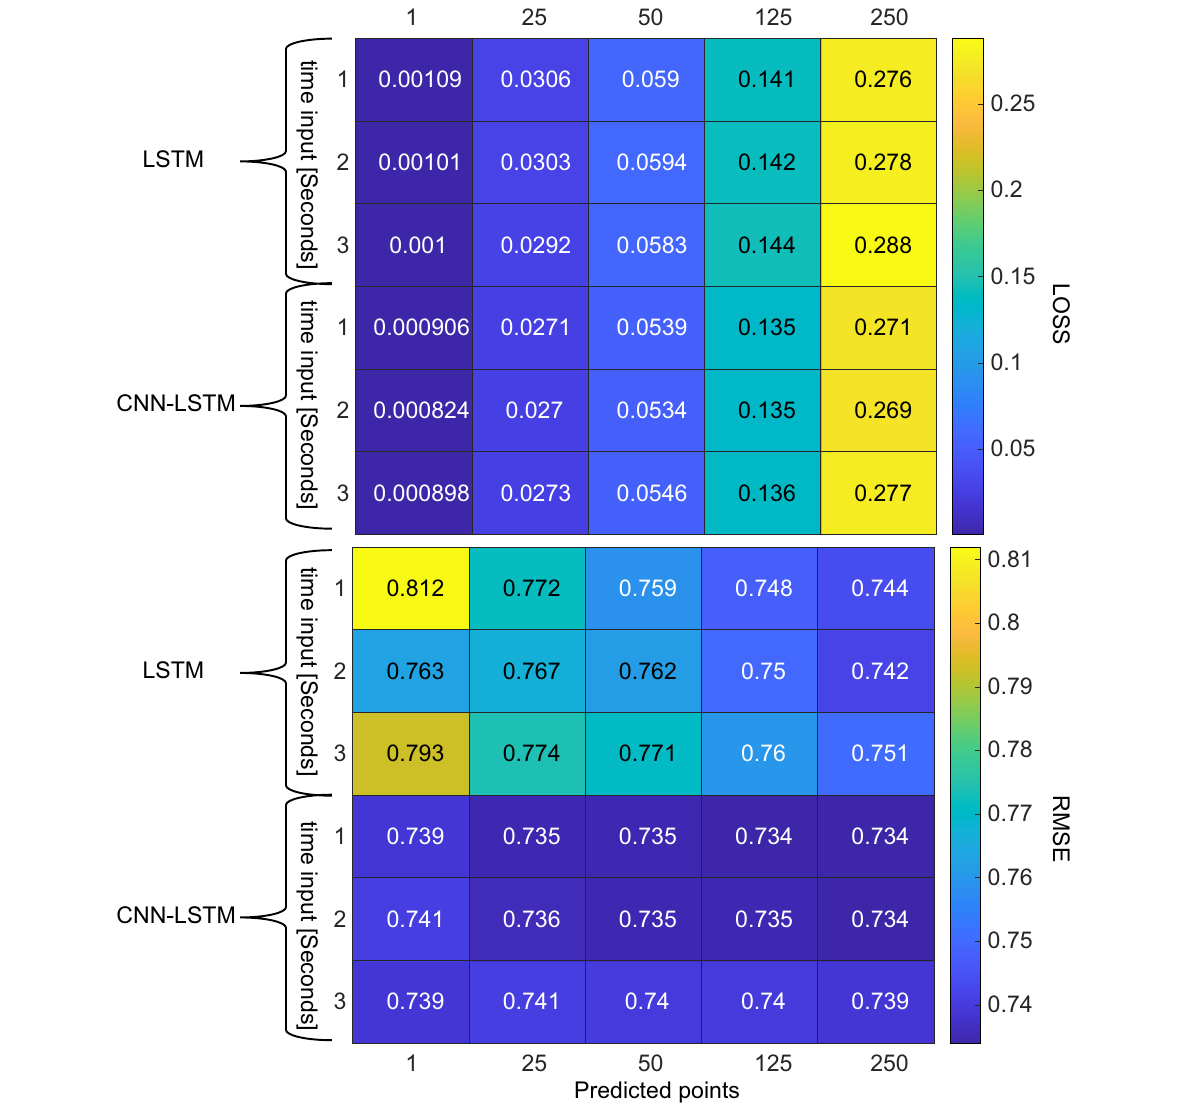
Table 5 Performance comparison for forecasting